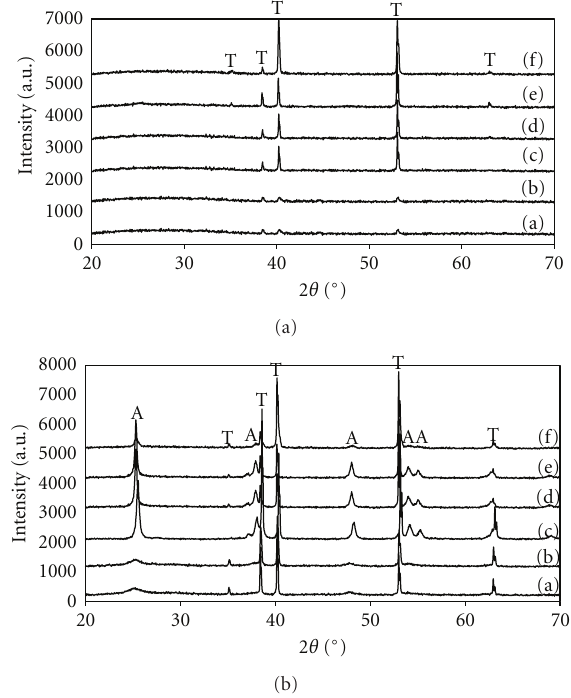
Figure 5: (a) XRD patterns of as-anodized TiO 2 nanotube arrays fabricated at (a) 10 ◦ C, (b) 20 ◦ C, (c) room temperature, (d) 40 ◦ C, (e) 60 ◦ C, and (f) 80 ◦ C; (b) XRD patterns of annealed TiO 2 nanotube arrays fabricated at (a) 10 ◦ C, (b) 20 ◦ C, (c) room temperature, (d) 40 ◦ C, (e) 60 ◦ C, and (f) 80 ◦ C after annealing at 400 ◦ C in argon atmosphere (A: anatase TiO 2 ; T: titanium).